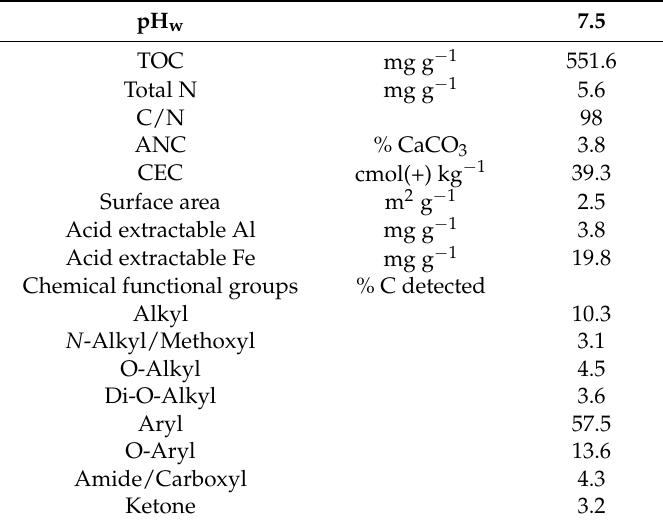
Table 1. Properties of eucalyptus biochar 550 °C.